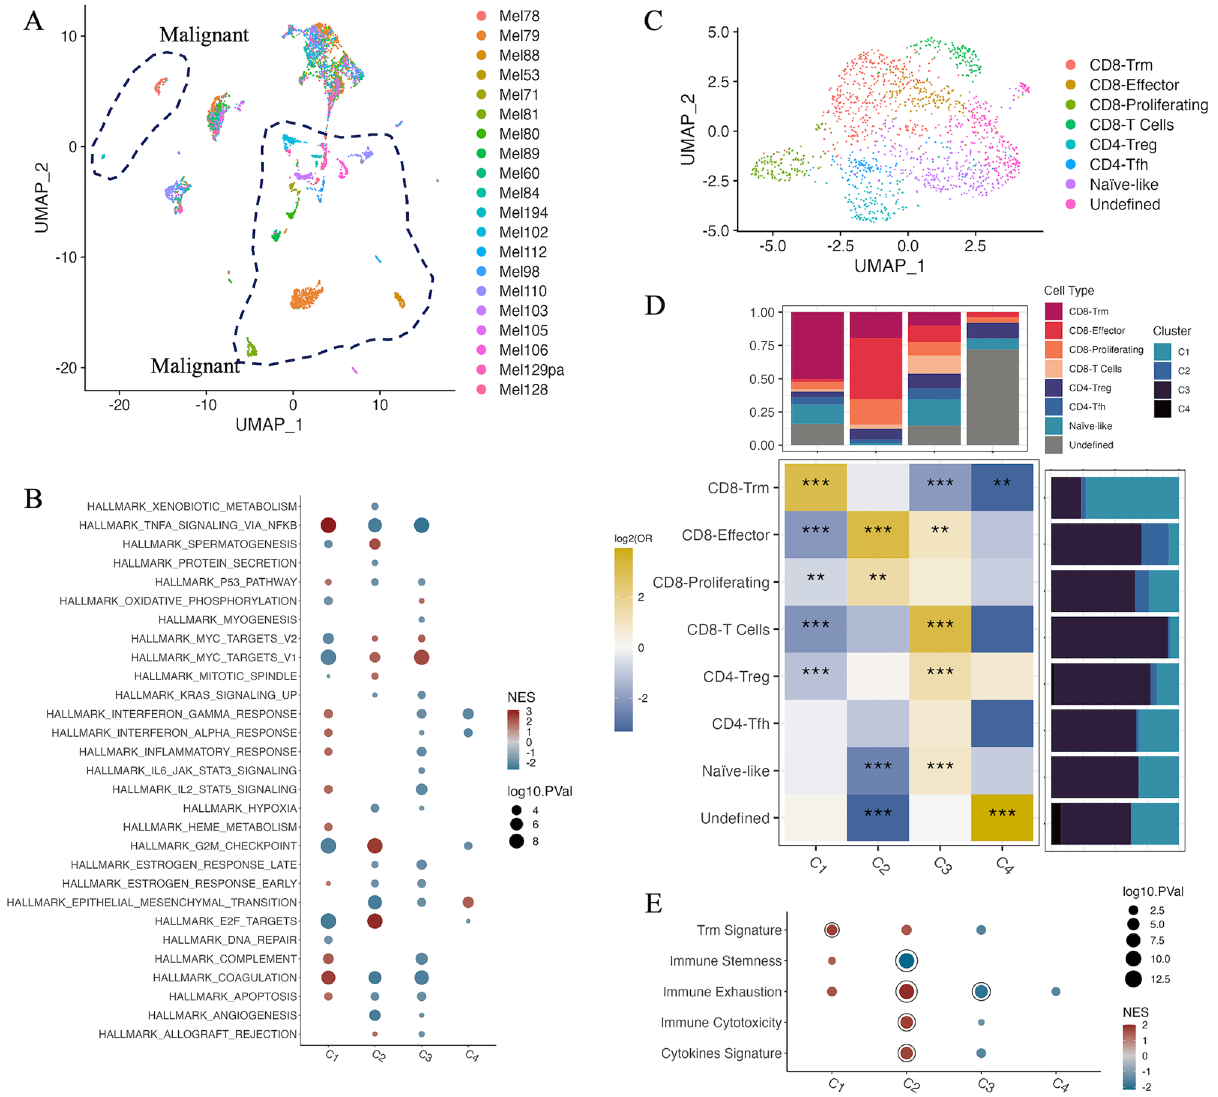
Figure 4. Biological processes of various cell types across APM clusters. ( A ) UMAP analysis of all cells (n = 5235) across 20 patients in the Jerby-Arnon scRNA-seq cohort. ( B ) Pathway enrichment analysis in malignant cells across APM C1-C4 computed by GSEA. The hallmark gene category annotated by MSigDB was used. Asterisks denote proinflammatory pathways. Pathways with FDR < 0.01 are shown. Colors represent normalized enrichment scores (NES), and dot sizes represent log10 (BH-adjusted p-value). ( C ) UMAP analysis of the T cell population. The cluster annotations were defined based on canonical and subset-selective markers between clusters. ( D ) Differential enrichment of T cell subsets across APM C1-C4. Odds ratios (OR) and p-values were calculated by two-sided Fisher’s exact test. ggplot function in ggplot2 version 3.4.0 (https:// ggplo t2. tidyv erse. org) was used to generate the heatmap. Color scale in the heatmap represents log2 (OR). Asterisks denote significant BH-adjusted p-values adjusted (*p < 0.05; **p < 0.01; ***p < 0.001). Bar plots show fractions of cell population within a cluster or cell type as indicated. ( E ) Functional enrichment analysis in the T cell population across APM C1-C4. Pathways with FDR < 0.25 are shown. Circles denote FDR < 0.05. Immune signatures are provided in Supplementary Table